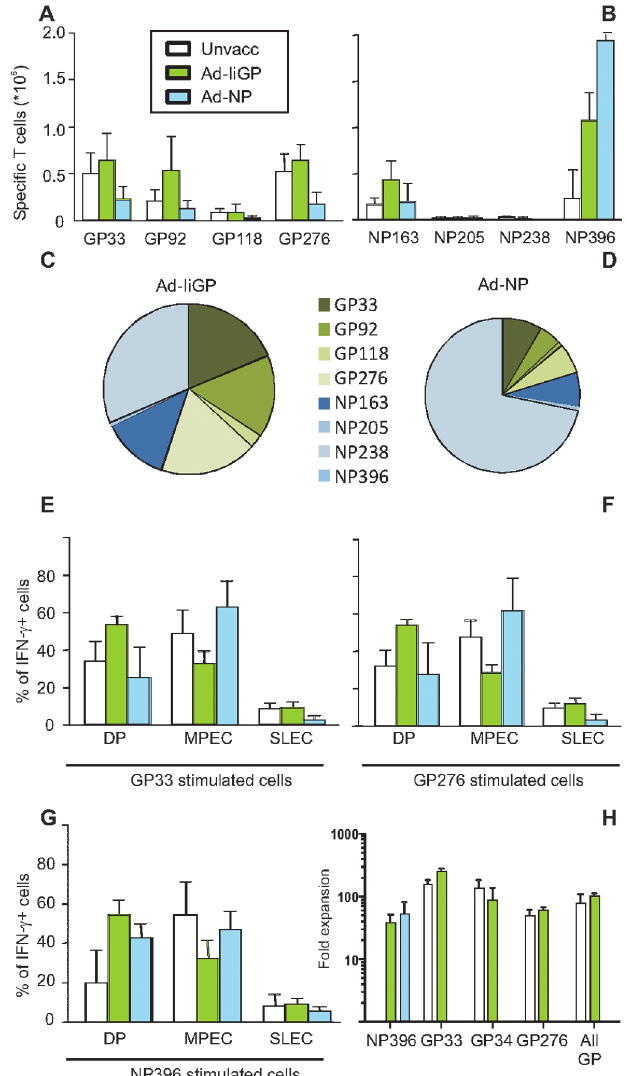
Fig 5. Long term immune responses, phenotype and secondary in vivo expansion. Mice were either infected with LCMV clone 13 or Ad-IiGP or Ad-NP vaccinated and then challenged with LCMV clone 13 as indicated. One year after LCMV clone 13 infection, mice were sacrificed and spleens were harvested for characterization of the CD8+ T cell response. a-b ) Enumeration of CD8+ T cells responding to specific GP ( a ) or NP ( b ) peptide stimulation with interferon- γ production. c-d ) Fraction of CD8+ T cells from Ad-IiGP ( c ) and Ad-NP ( d ) vaccinated mice responding to individual specific peptides as a fraction of total numbers of GP plus NP specific cells. The small difference in the sizes of the pie charts reflects the difference in the averages of total numbers of cells recognizing GP and NP epitopes in the two groups. e-g ) phenotype of responding cells. The percentage of cell producing interferon- γ in response to GP33 ( e ), GP276 ( f ) or NP396 ( g ) peptide, that also expressed certain combinations of CD127 and KLRG-1 are depicted, CD127+/KLRG1+ (DP), CD127+/KLRG1- (MPEC) and CD127-/KLRG1+ (SLEC)). Shown are mean + SEM for 8 animals per group. h ) Expansion following vaccinia GP or vaccinia NP challenge. 10.000 GP33+GP34+GP276 or 10.000 NP396 specific cells pooled from the animals described above (CD45.2+) were transferred to na ï ve recipients (CD45.1+), and these were challenged the following day with vaccinia expressing NP (NP396) or GP (GP33, GP34, GP276 and GP pool). Fold expansion is the number of donor T cells quantified by the indicated tetramer in vaccinia infected recipients as compared to the number detectable in unchallenged recipients. Shown are mean +SEM of 5 recipient mice per